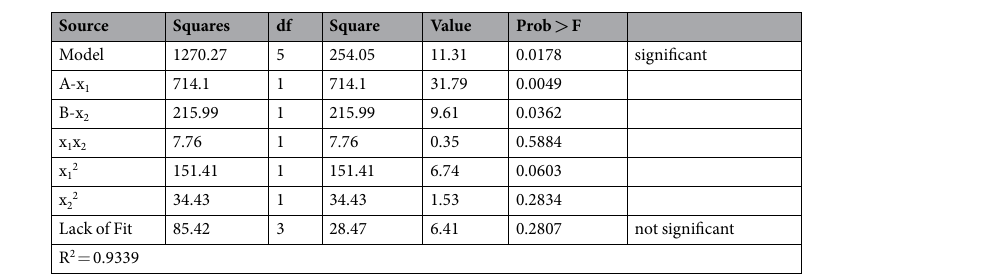
Table 2. ANOVA for a quadratic response surface